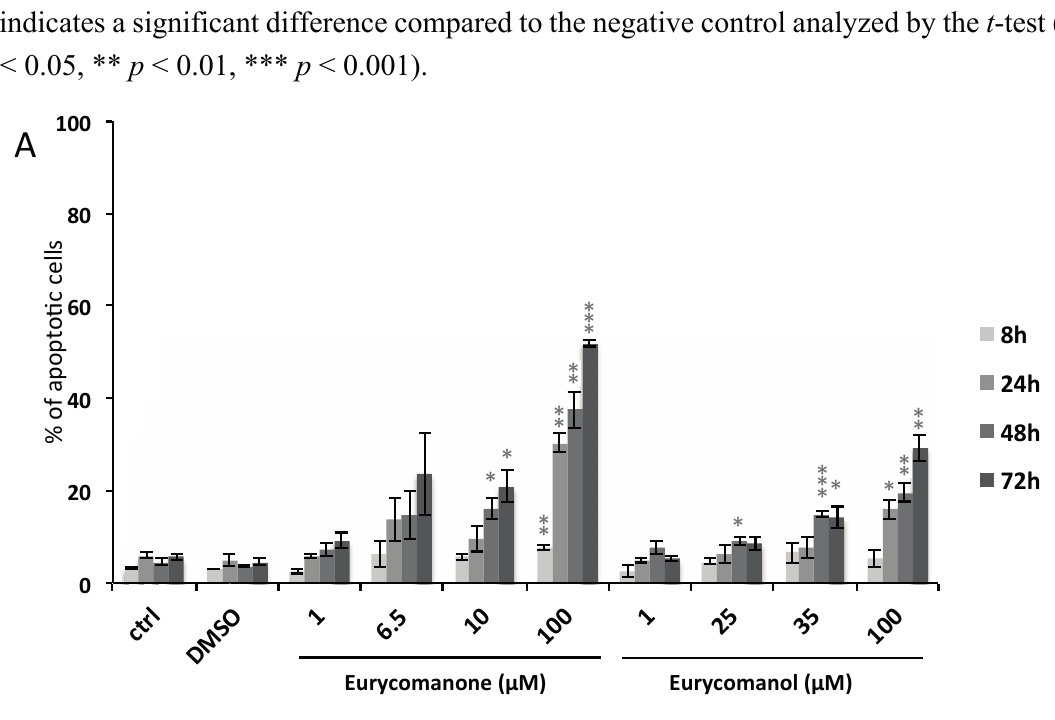
Figure 4. The effect of eurycomanone and eurycomanol on the induction of apoptosis in K562 ( A ) and Jurkat ( B ) cells. Apoptosis was evaluated by quantification of cells presenting fragmented nuclei by fluorescence microscopy after Hoechst staining. DMSO corresponds to solvent-treated control. Each value is the mean ± SEM of three independent